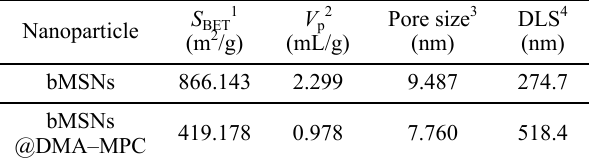
Table 1 Structural properties of bMSNs and bMSNs@DMA– MPC nanoparticles.